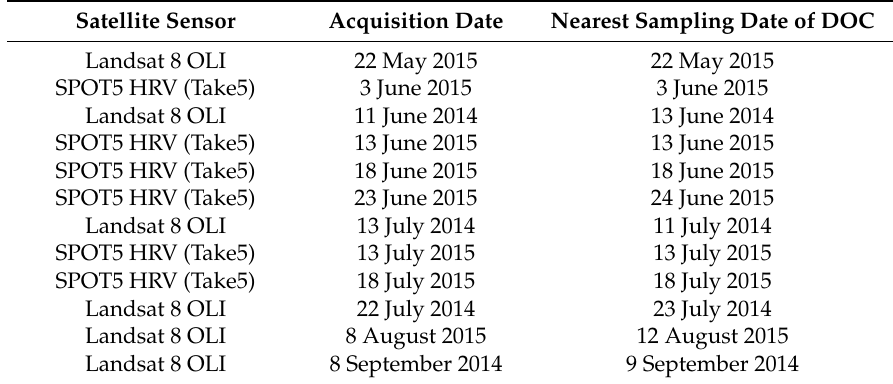
Table 1. List of the available SPOT5 Take 5 and Landsat 8 scenes to calibrate an empirical CDOM retrieval algorithm in the Yenisei River during the open-water-season in 2014 and